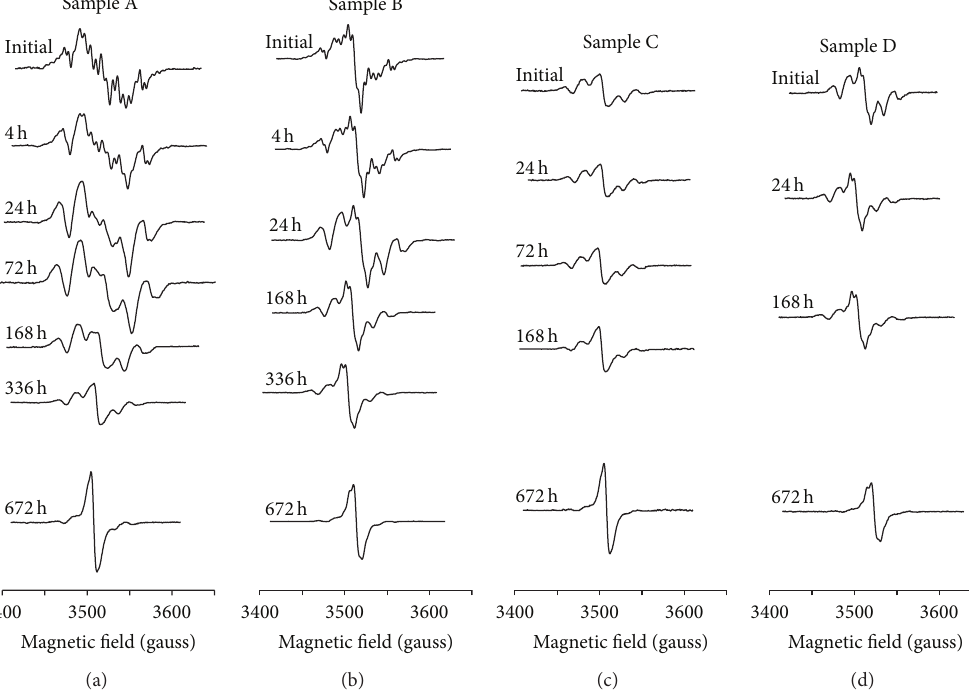
Figure 8: ESR spectrum plotted as a function of oxidation time in air for 678 hours: (Sample A) virgin UHMWPE powder 100-kGy irradiated; (Sample B) vitamin E blended UHMWPE powder 100-kGy irradiated; (Sample C) virgin UHMWPE powder 65-kGy irradiated; (Sample D) vitamin E blended UHMWPE powder 65-kGy irradiated. ∗ (Note: all the spectra are on the same 𝑦 -axis scale except Sample B. The scale of Sample B is twice the all other samples in the